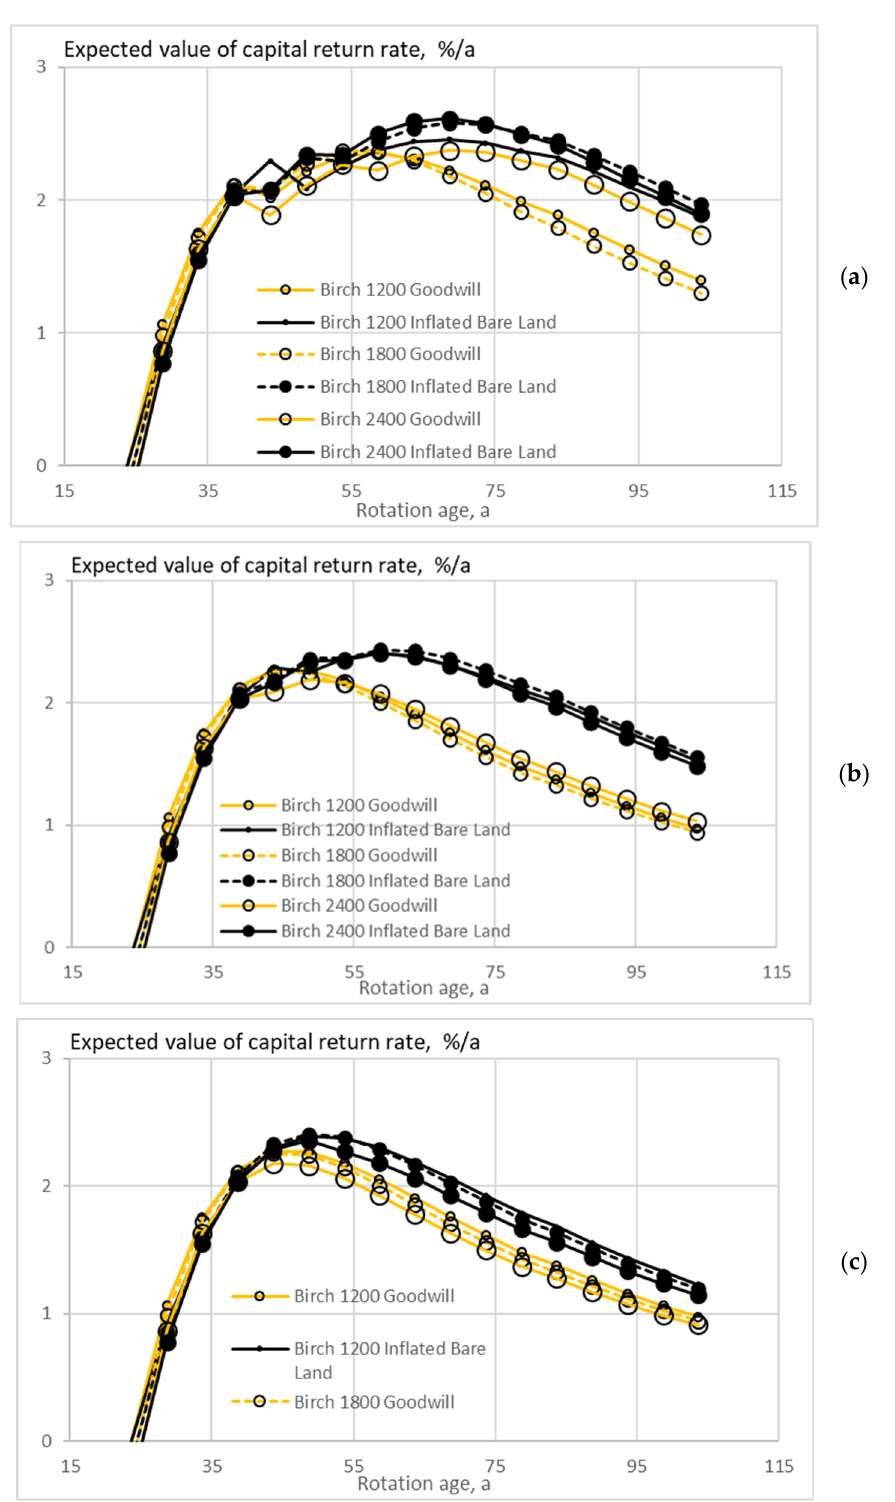
Figure 4. The expected value of capital return rate on spruce stands of different initial sapling den- sities, as a function of rotation age, when the growth model is applied as early as applicable, without any thinning restriction ( a ), in good-quality trees of at least 238 mm of diameter only removed in thinning ( b ), and without commercial thinning ( c ). Inflated capitalization is introduced either as proportional goodwill or as inflated bare land value.